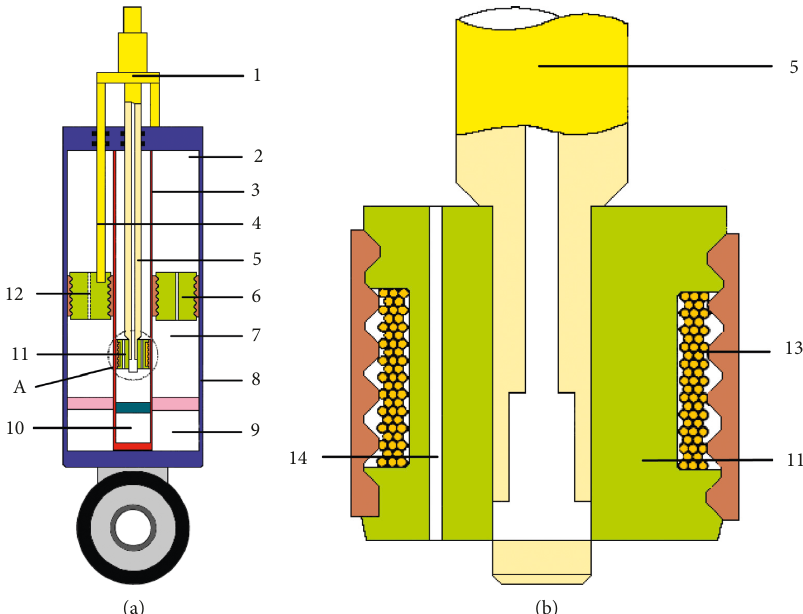
Figure 9: (a) A schematic cross-sectional view of a double-tube shock absorber using both MRF and an ordinary fluid. (b) An enlarged cross-sectional view of a portion “A” shown in Figure 9(a). 1, rod fixture; 2, first working chamber; 3, inner cylinder; 4, first piston rod; 5, second piston rod; 6, first piston; 7, second working chamber; 8, outer cylinder; 9, first accumulator; 10, second accumulator; 11, second piston; 12, first orifices; 13, coil; 14, second orifices [52].